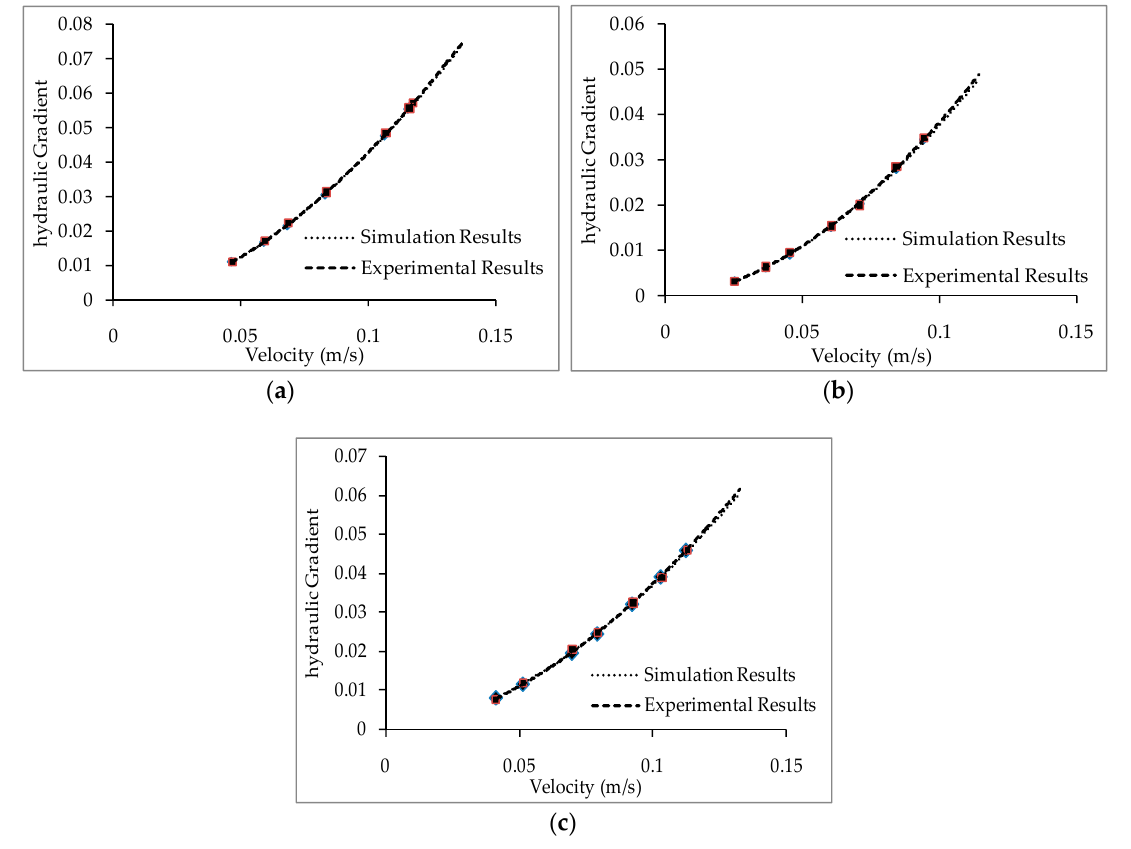
Figure 10. Comparison of simulation and experimental results for 34.78 mm media packed with ( a ) 41.72%; ( b ) 44.70%; and ( c ) 46.34% porosities.